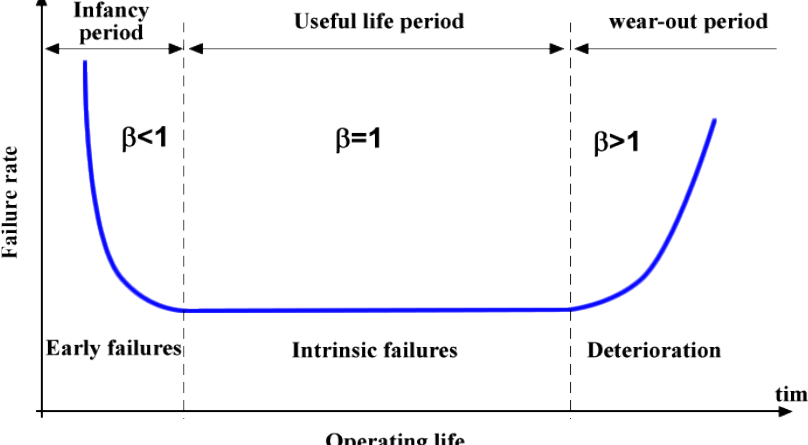
Figure 2. The “bathtub” curve illustrating the reliability of technical systems.